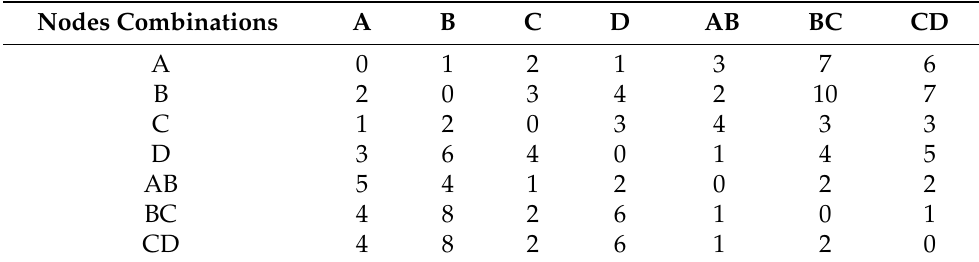
Table 2. Priority matrix for the graph of Figure 3 nodes A, B, C, and D. Nodes Combinations A